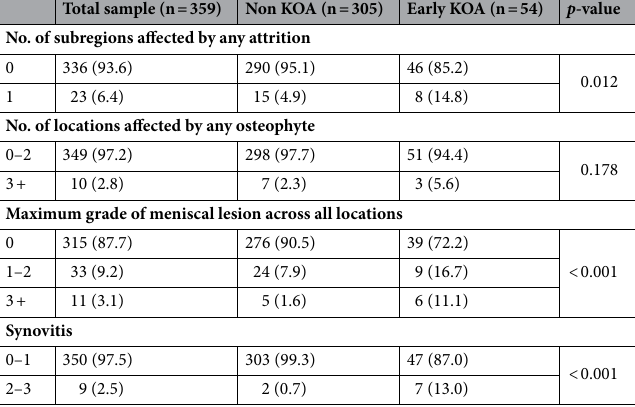
Table 3. The distribution of MRI lesions of study participants. The values represent the number (percentage of the whole population) of MRI lesions of all participants, participants with early KOA, and those without KOA. Differences among the two groups were compared by chi-square test. A p -value indicates the significance of difference between participants with and without early KOA.